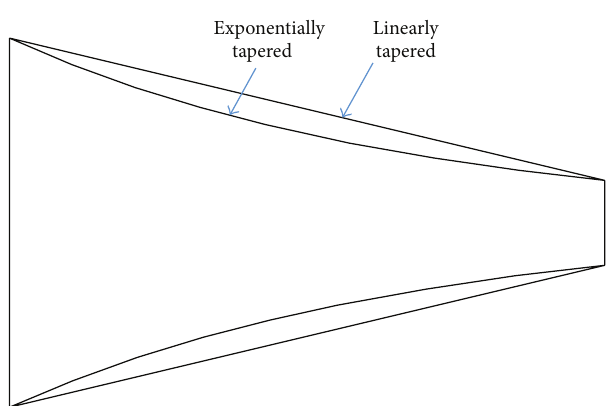
Figure 16: Exponentially ( 𝑐 = 28.92 ) and linearly tapered energy harvesters with the same base and tip ( 𝑏 𝑇 ) widths.